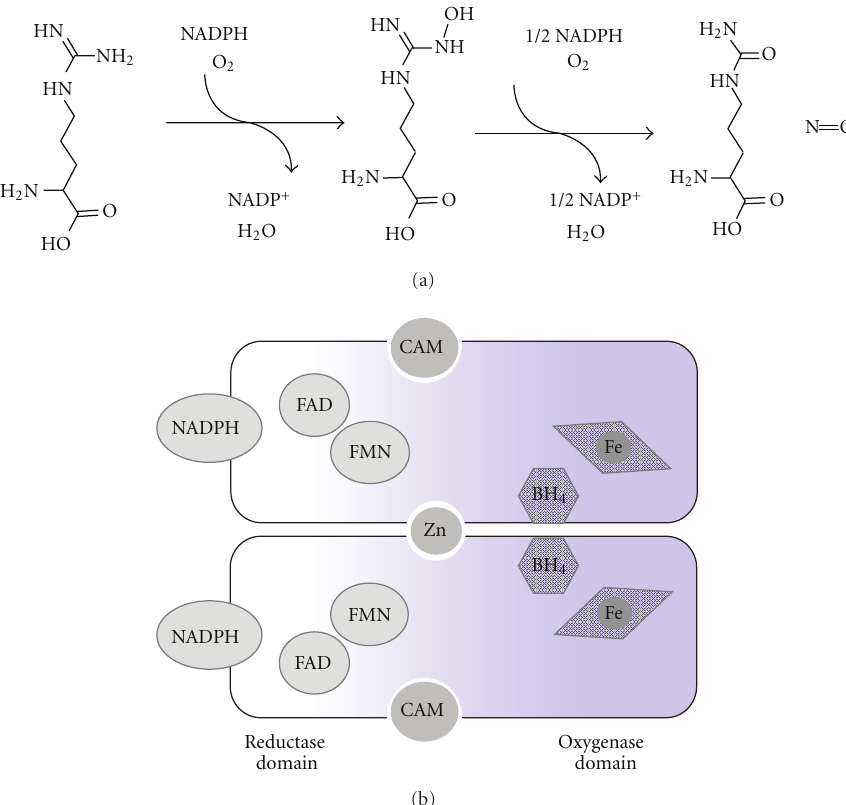
Figure 1: (a) Scheme of the two-step oxygenation of arginine catalysed by NO synthase. (b) Scheme of the mature NOS dimer: Each subunit contains tetrahydrobiopterin (BH 4 ) and heme near the active site of the oxygenase domain (grey). The reductase domain (white) houses the NADPH-binding site as well as two-electron transfer cofactors (flavine adenine dinucleotide FAD and flavine mononucleotide FMN). The zinc bound at the interface mediates dimerisation. Calmodulin (CAM) binding regulates the